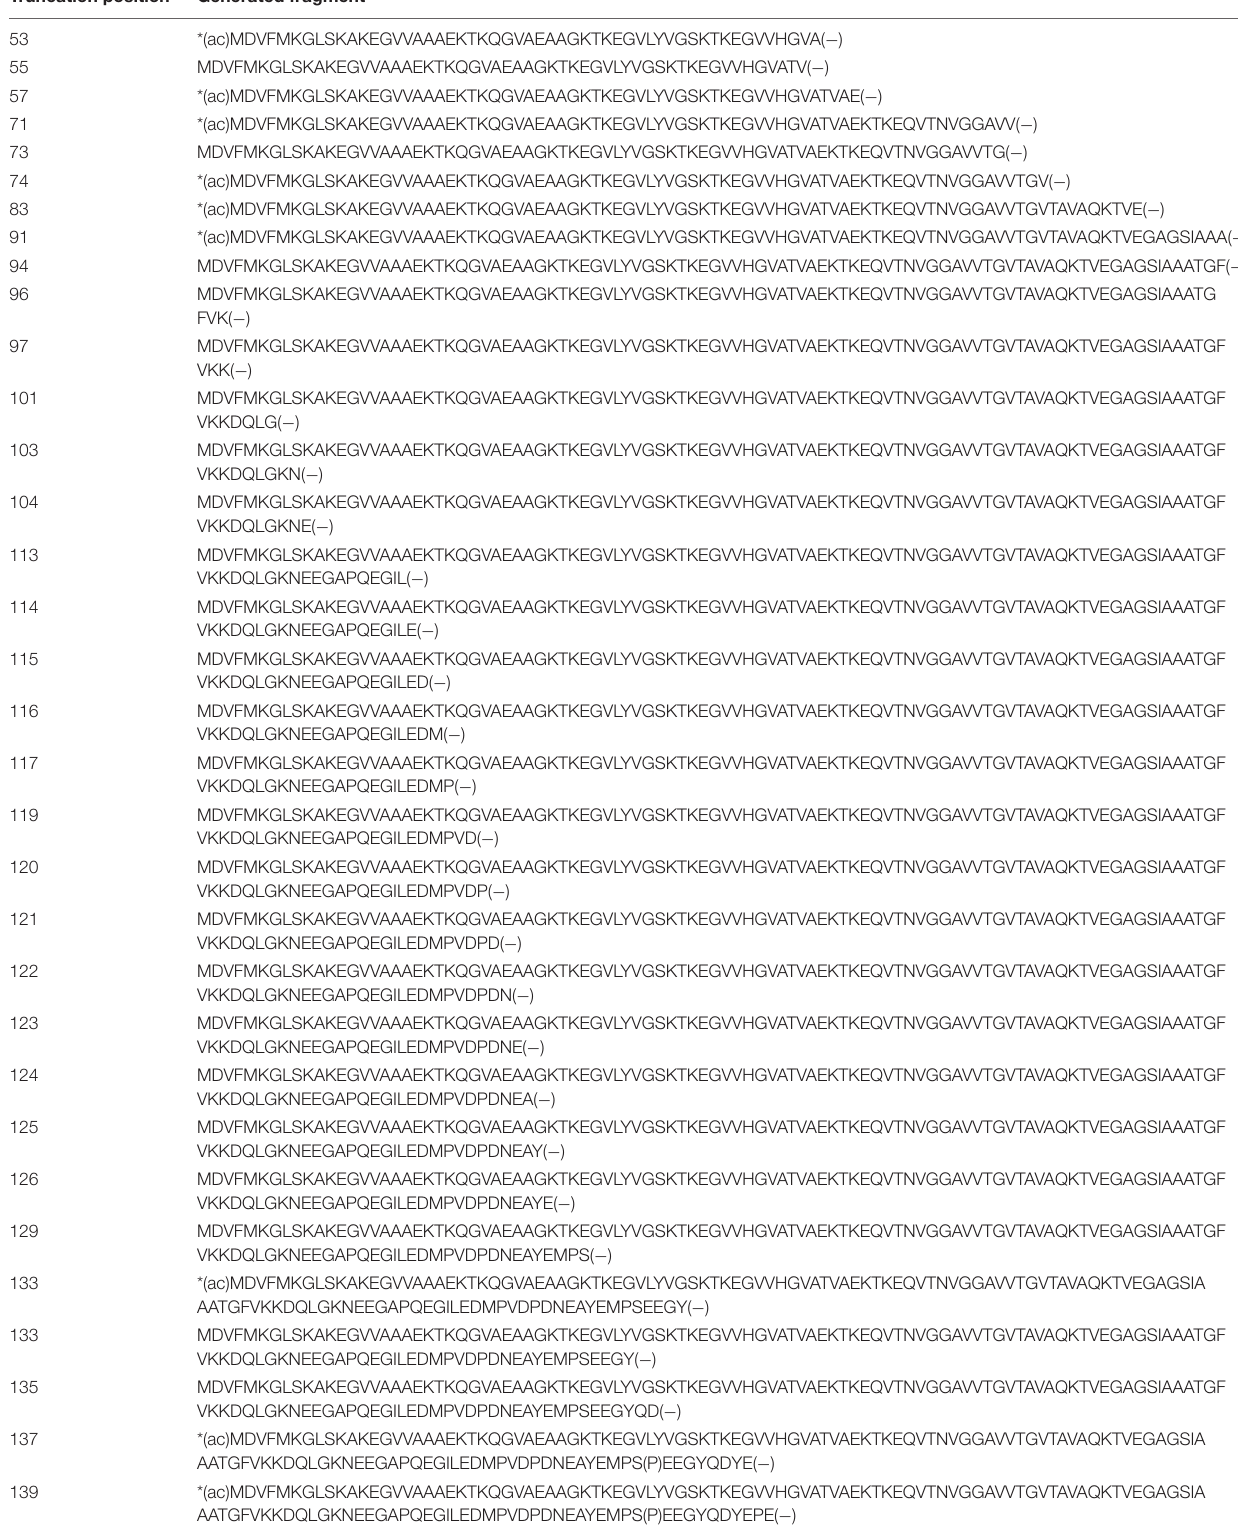
TABLE 2 | Alpha synuclein truncation products (AA-): Cter